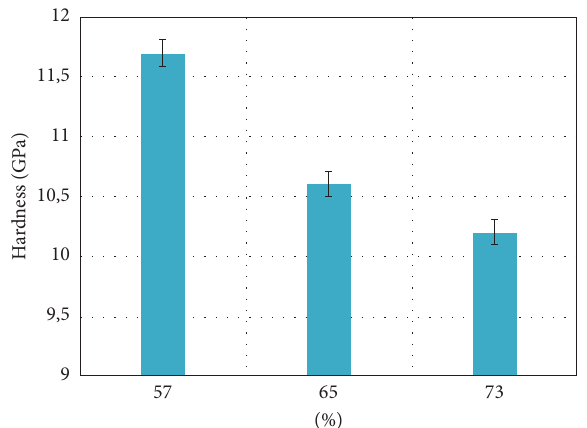
Figure 5: Graph of the hardness distribution of the Cr 3 C 2 -NiCr-based gradient detonation coating as a function of barrel flling.